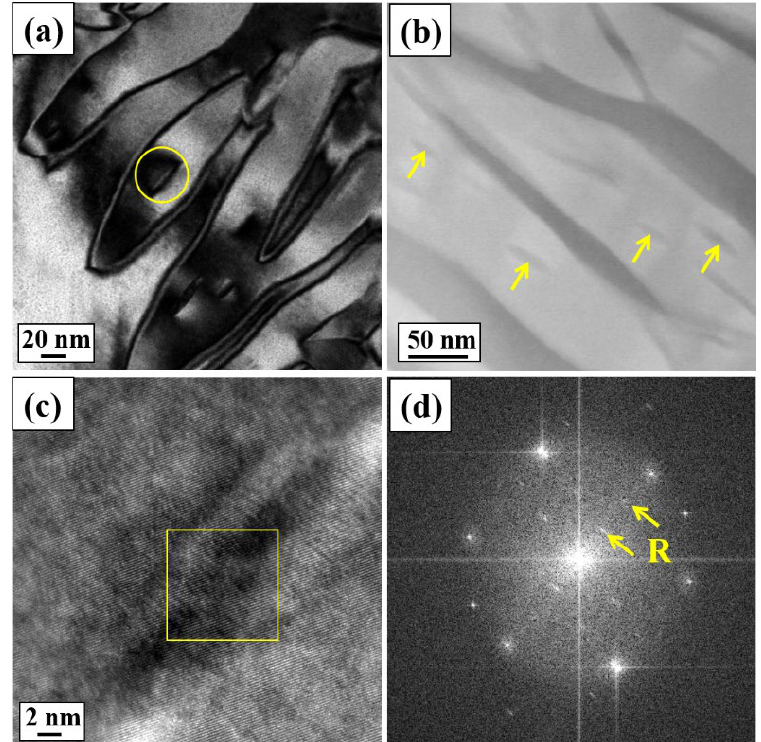
Figure 4. ( a ) The fine lath-like NiTi phase in the lenticular Ni 4 Ti 3 phase; ( b ) a STEM image; ( c ) a high-resolution TEM image of the lath structure; ( d ) and the phase identification results according to the diffraction points of the FFT image in ( c ).